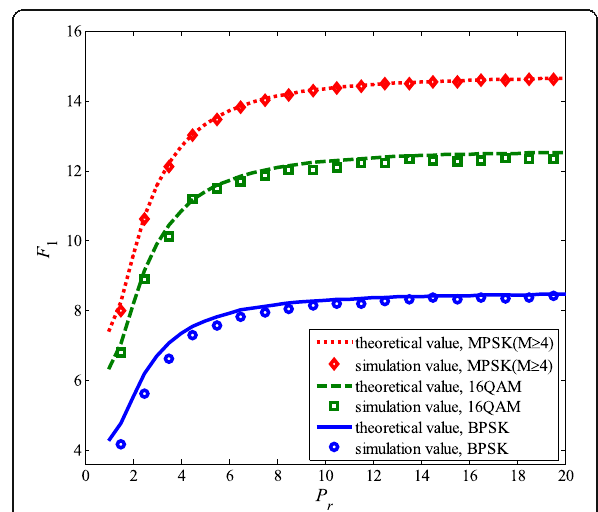
Fig. 1 The HOS feature F 1 as a function of the power ratio P